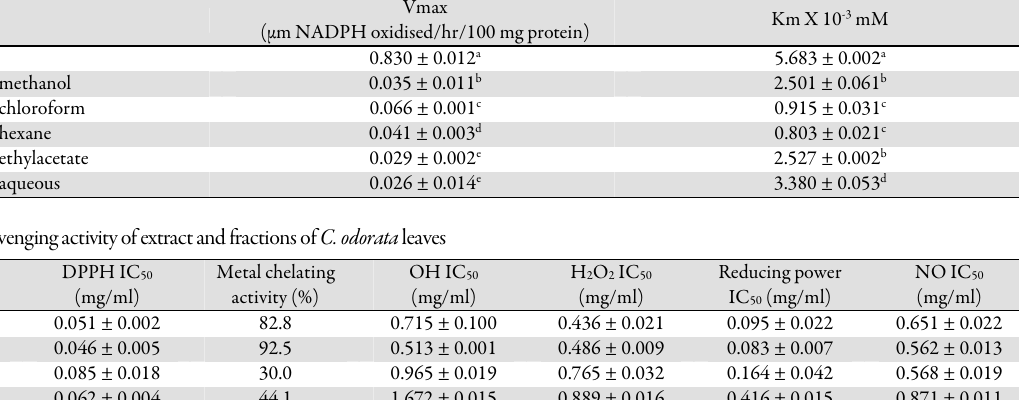
Table 4. Kinetics parameters of aldose reductase enzyme in the presence of different fractions of C. odorata leaves Extract/Fraction